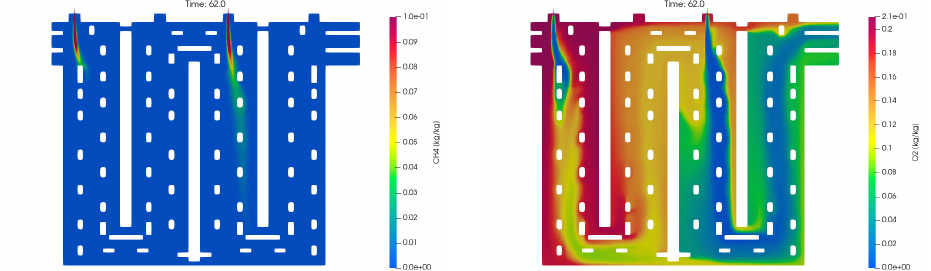
Figure 8. Mass fraction of CH 4 ( left , truncated to 0.1) and O 2 on the symmetry plane ( right ) at t = 62 s of computation time.